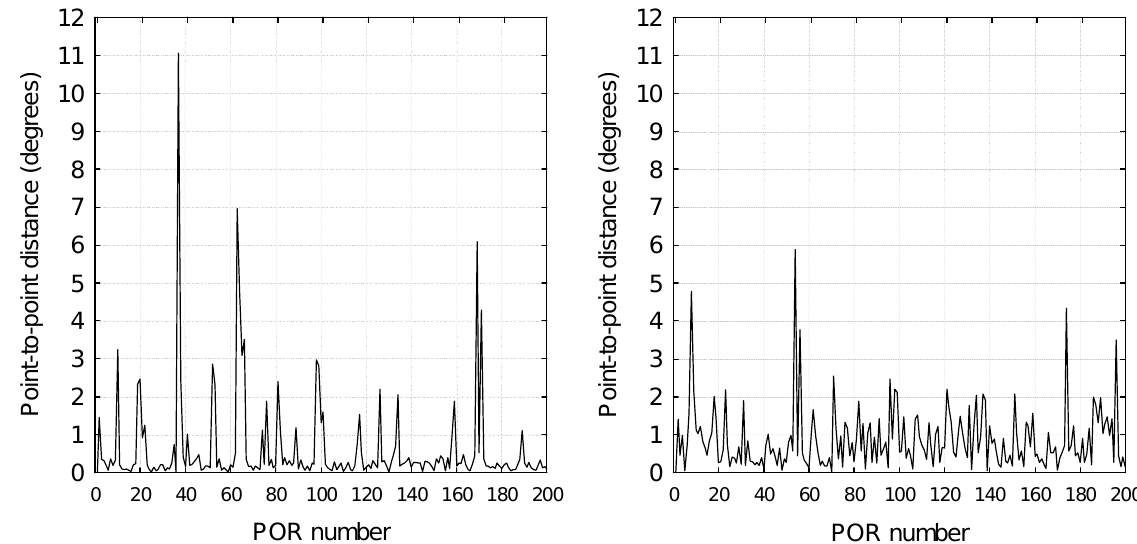
Figure 2. Point-to-point distances of the first 200 PORs of the same participant recordings of Figure 1